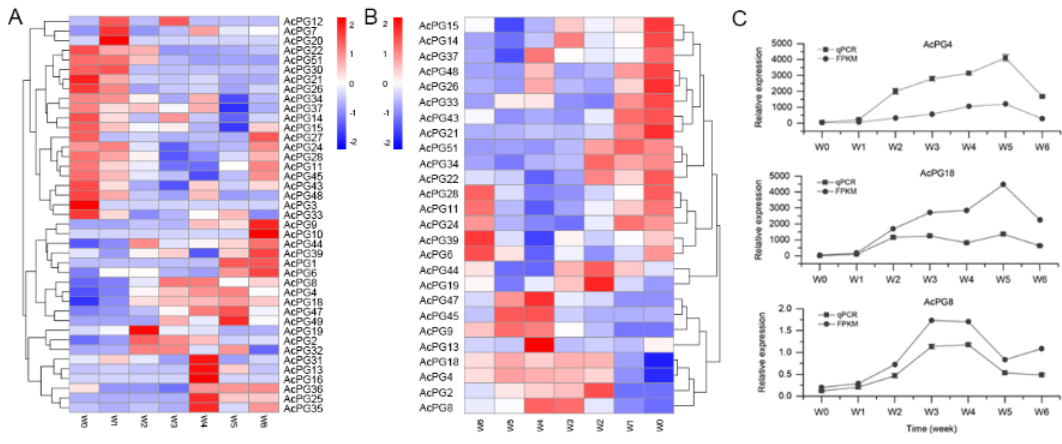
Figure 5. Expression pattern analysis of selected AcPG genes during kiwifruit ‘Donghong’ softening. Heat maps showing the hierarchical clustering of 41 AcPGs based on their expression patterns determined by transcriptome analysis ( A ) or the hierarchical clustering of 26 selected AcPG genes based on their expression patterns determined by qPCR assay ( B ), respectively. ( C ) The expression profiles of three potential AcPG genes probably involved in pectin degradation ( AcPG4 , AcPG8 and AcPG18 ) are shown.